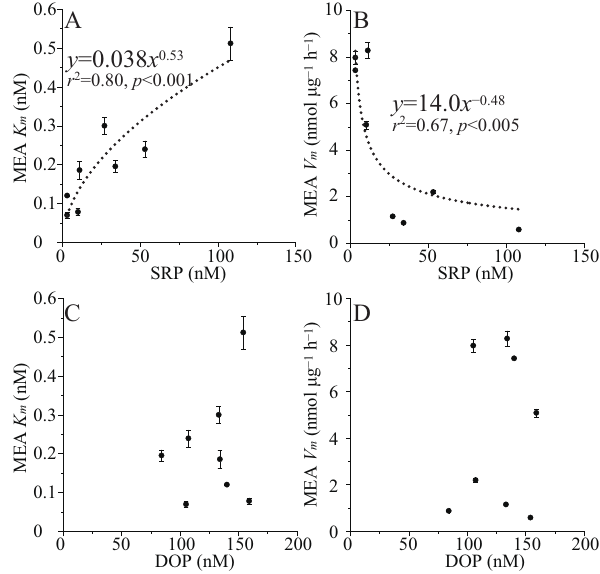
Fig. 6 Fig. 6. Half-saturation constants (A, C) and chlorophyll a - normalized maximum hydrolysis rates (B, D) of phosphate mo- noesterase plotted against SRP (A, B) and total DOP (C, D) con- centrations. Error bars indicate 95% confidence intervals of curve